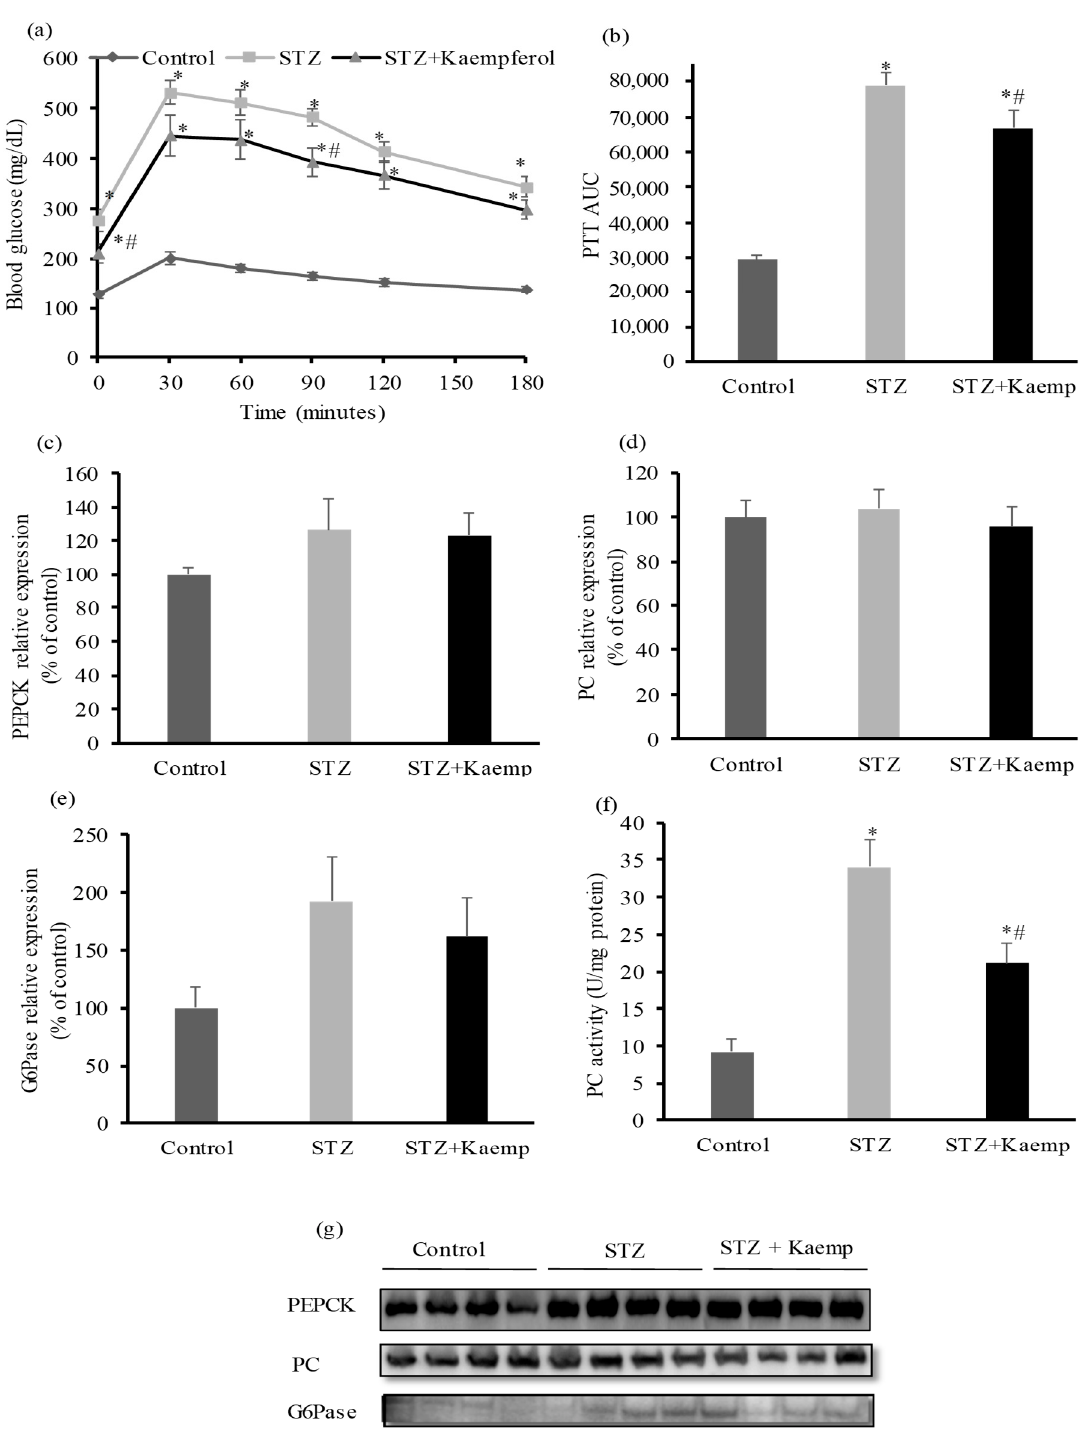
Figure 4. Kaempferol treatment for 12 weeks decreased hepatic glucose production from pyruvate and reduced PC activity without altering protein expressions of PC, PEPCK, or G6Pase in STZ-induced diabetic mice. PTT ( a ) was performed as described in the Method section, and the area under the curve (AUC) of PTT ( b ) was calculated. ( c , g ) PEPCK, ( d , g ) PC, and ( e , g ) G6Pase protein levels in the livers were measured by Western blot normalized to total protein contents in whole cell lysates. ( f ) PC activity was measured as described in the Method section. Data are shown as Mean ± SEM ( n = 8–9). * p < 0.05 vs. non-diabetic mice; # vs. STZ-induced diabetic mice. Control: nondiabetic mice; STZ: STZ-induced diabetic mice; STZ + Kaemp: STZ-induced diabetic mice treated with kaempferol (50 mg/kg